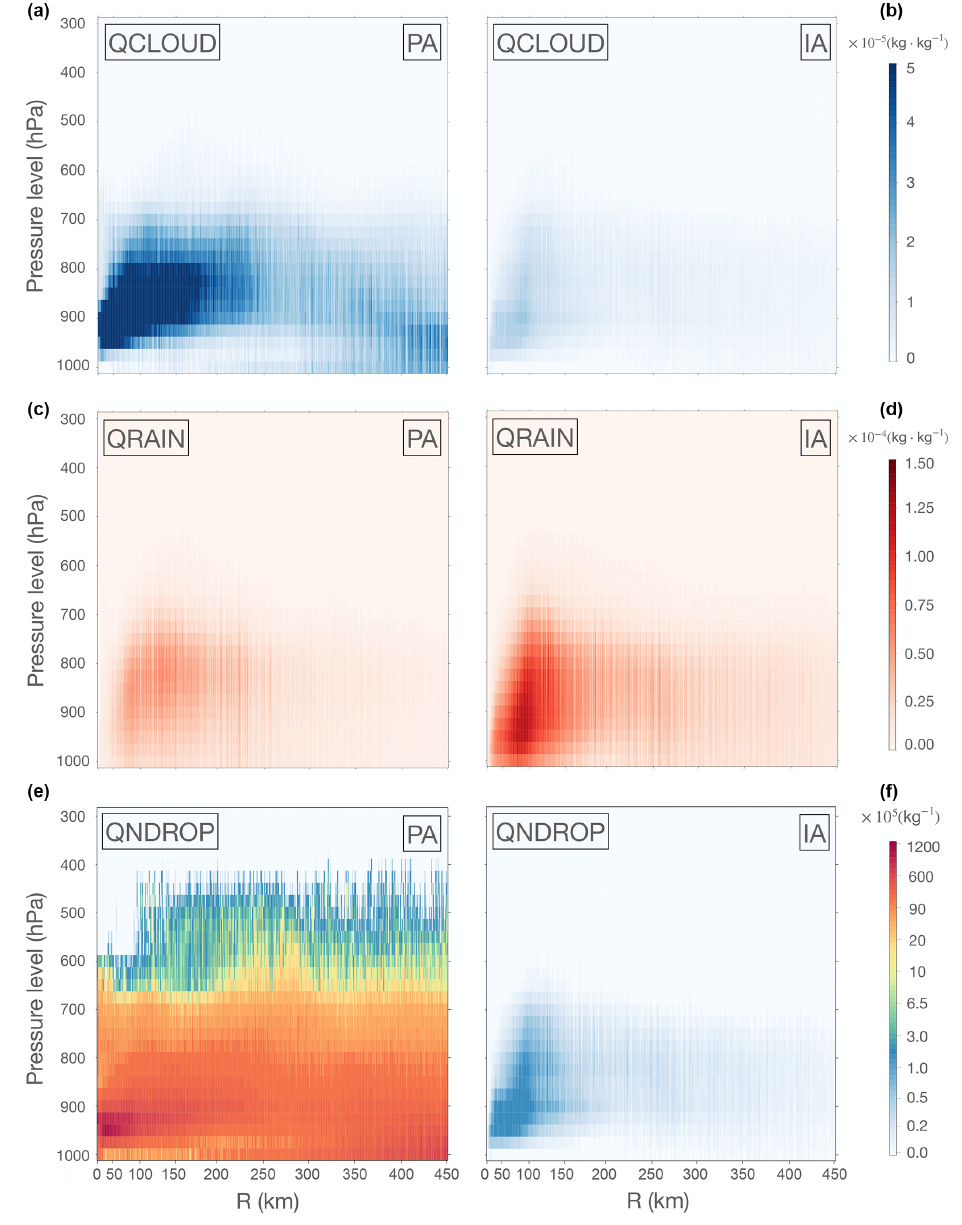
Figure 7. Time-averaged and azimuthally averaged height–radius cross sections of ( a, b ) cloud water mixing ratio (QCLOUD, kgkg − 1 ), ( c, d ) rain water mixing ratio (QRAIN, kgkg − 1 ) and (e,f) droplet number mixing ratio (QNDROP, kg − 1 ) for PA ( a, c, e ) and IA ( b, d, f ) simulations of Rolf starting with 36h of run-up time (i.e., on 5 November 2011 at 00:00UTC), both without spectral nudging. Distance from the medicane center is represented on the horizontal axis and atmospheric pressure levels on the vertical axis. The three scales must be multiplied by the factor preceding the units in the legend